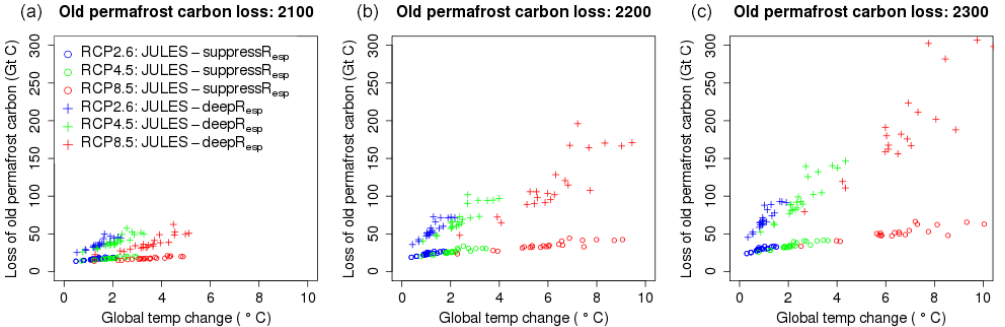
Figure 10. The relationship between the loss of old carbon from the permafrost region and change in global temperature at years 2100, 2200 and